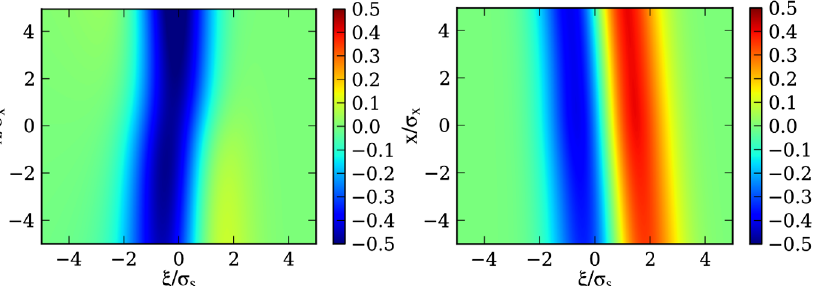
FIG. 11. The transient longitudinal radiation field E rad when beam has rotated 10 (cid:10) . The beam parameters are the same as in Fig. 9 and (cid:2) ¼ 100 .